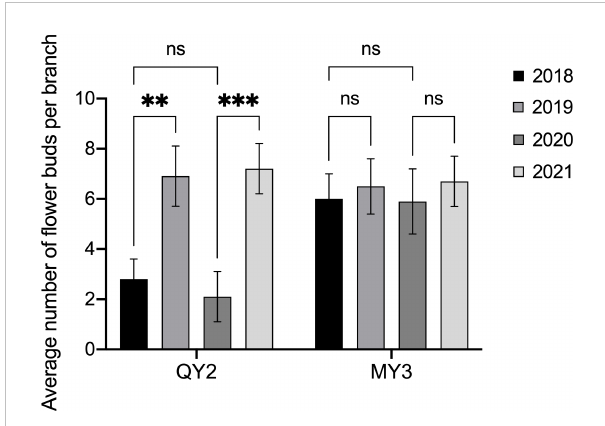
FIGURE 2 Flower buds in successive multiple growing seasons of two Camellia oleifera cultivars. ** p<0.01, *** p<0.001, ns: Not signi fi cant. All values represent the means of biological